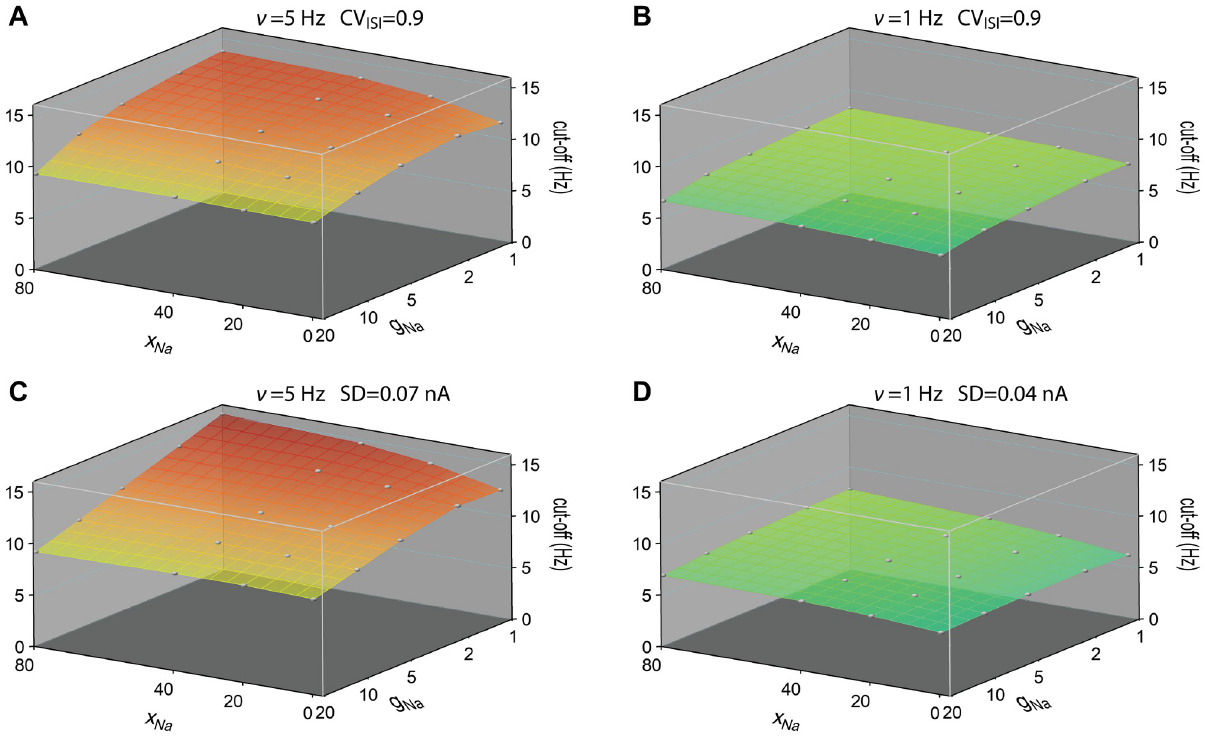
Fig 5. Cutoff frequencies of dynamic gain curves as a function of sodium peak conductance and AP initiation site. A and B For each pair of AP initiation site and sodium peak conductance, the dynamic gain curve was calculated at 5Hz and 1Hz firing rates working points. CV values were fixed at 0.9 ± 0.05. C and D The dynamic gain curves were calculated at 5Hz and 1Hz firing rate with std of stimuli fixed at 0.07nA and 0.04nA. Cutoff ffiffiffi p frequency was the frequency to which the dynamic gain decayed by a factor of 2 . Correlation time of background current was 5ms. x Na ranged from 0 μ m to 80 μ m. Sodium peak conductance ranged from 1� g to 20� g , represented on a logarithmic scale. Grey points represent calculated data, Na Na continuous surfaces are obtained by Voronoi interpolation to allow for a continuous color